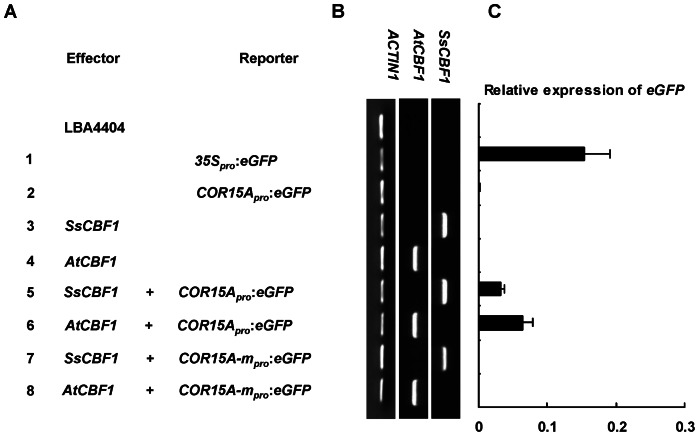
Transactivation of CRT/DRE cis-element containing promoter by SsCBF1 and AtCBF1.(A) Combinations of reporter and effector constructs used in the transient expression assays. Agrobacterium strain LBA4404 was used as a negative control. The 35Spro:eGFP construct was used as a positive control. The reporter eGFP gene was driven by the wild-type or mutant COR15A promoter. The effectors SsCBF1 and AtCBF1 genes were driven by the CaMV35S promoter. (B) Semi-quantitative PCR detection of SsCBF1, AtCBF1 and ACTIN1 expression in tobacco leaves infiltrated with different combinations of constructs as shown in (A). (C) qRT-PCR analysis of eGFP expression. qRT-PCR procedure was as described in Methods. The results are representative of three independent experiments.